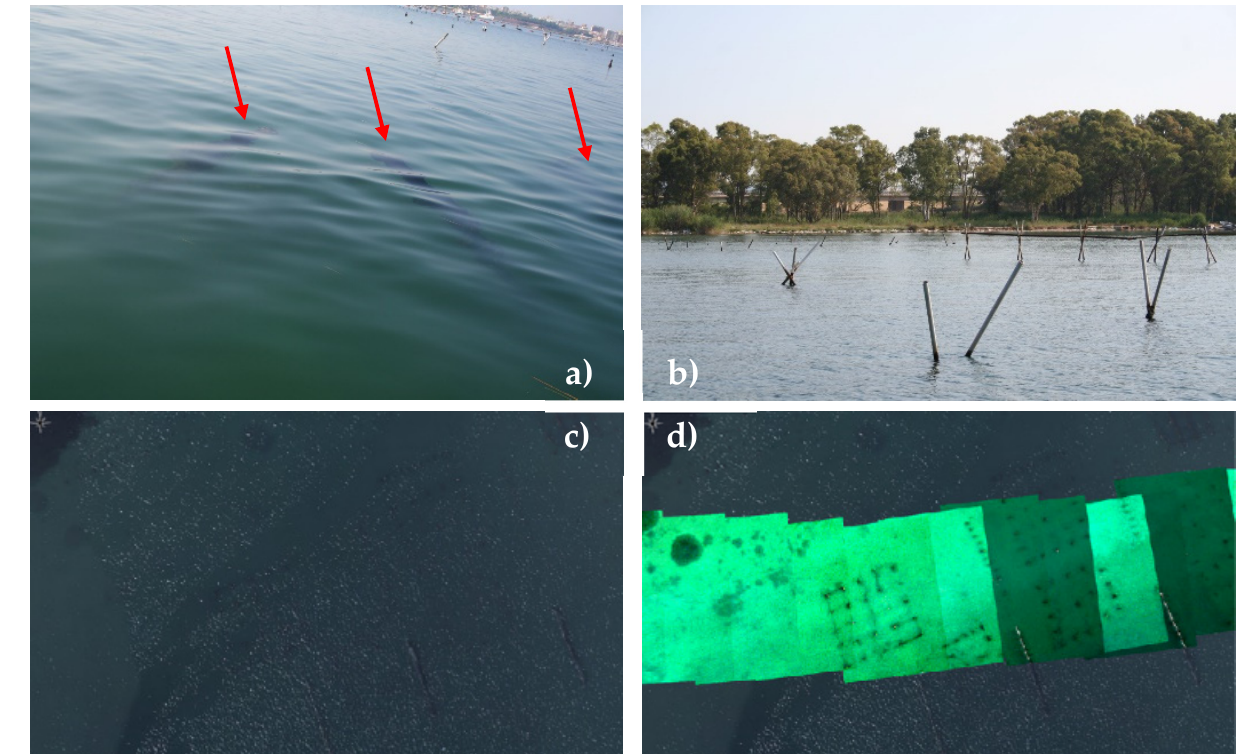
Figure 11. ( a ) Invisible and submerged poles (red arrows), (First Inlet of the Mar Piccolo, Puglia Region); ( b ) Abandoned mussel fields. First Inlet of the Mar Piccolo near Galeso river mouth, Puglia Region ( c ) Identification of an abandoned mussel farm. ( c ) Aerial image of Puglia in 2016; ( d ) LEOSS recent image on the right after the processing here reported. We could call it the “luminol” effect.